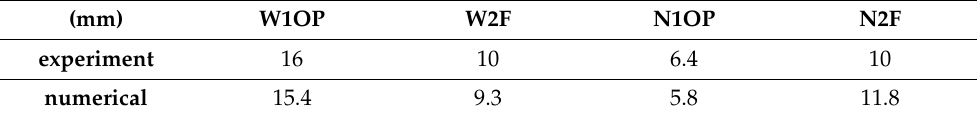
Table 3. Comparison of deflection between the numerical model and real structure.